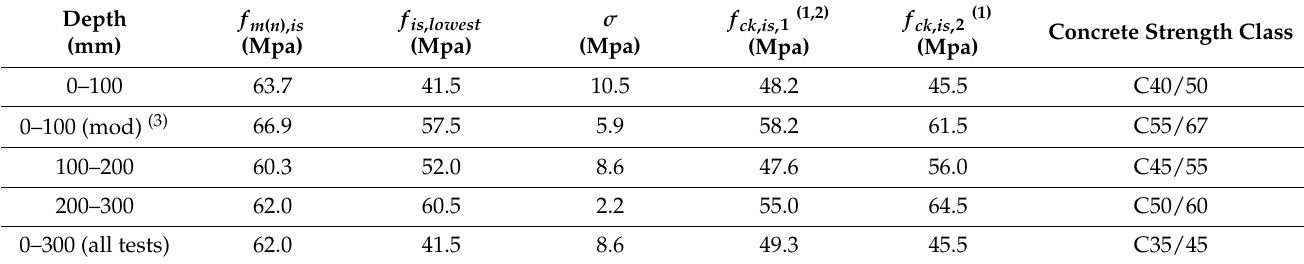
Table 5. Evaluation of the concrete strength class for the different depth ranges based on the mean and lowest in situ compressive strength ( f m ( n ), is and f is , lowest , respectively), and standard deviation σ , in accordance with EN 13791